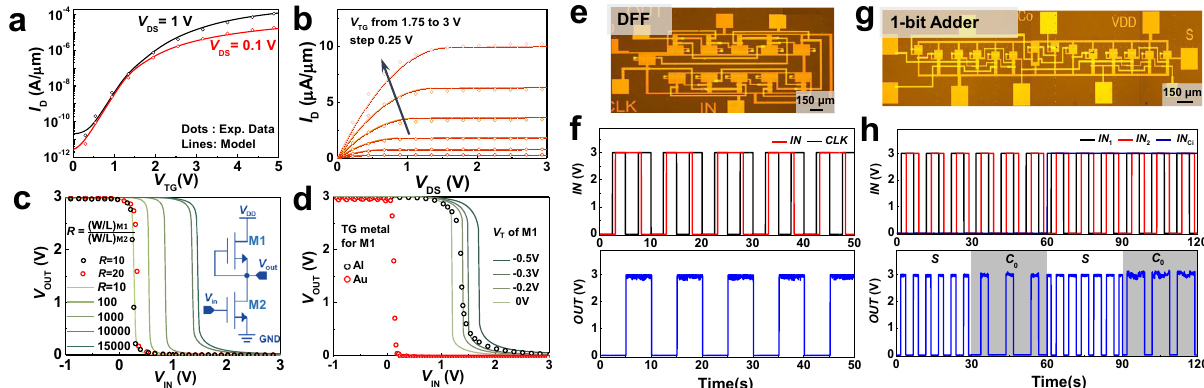
Fig. 3 Logic circuits based on MoS 2 TG-FETs. Experimental data (circular dots) and simulation (lines) for a , b transfer and output characteristics of MoS 2 TG-FETs, and c , d display voltage-transfer curves (VTCs) of an MoS 2 inverter with M1 and M2 FETs. The inset in c is the schematic of a MoS 2 pseudo- NMOS inverter. The geometry parameter R = (W/L) M1 /(W/L) M2 is used to adjust the switching point of the VTC curve in c , while a different method is used in d by independently tuning V T of M1. e is an optical microscope image of a MoS 2 -negative edge-triggered D fl ip- fl op (DFF) circuit, and f shows the corresponding experimental results. The upper two waveforms are inputs with a 0 – 3 V voltage swing, and the lower graph shows the measured output. g is an optical microscope image of a 1-bit MoS 2 full adder and h is the corresponding experimental results. The output signal of sum ( S ) and carry output ( C o ) is distinguished by the shaded gray